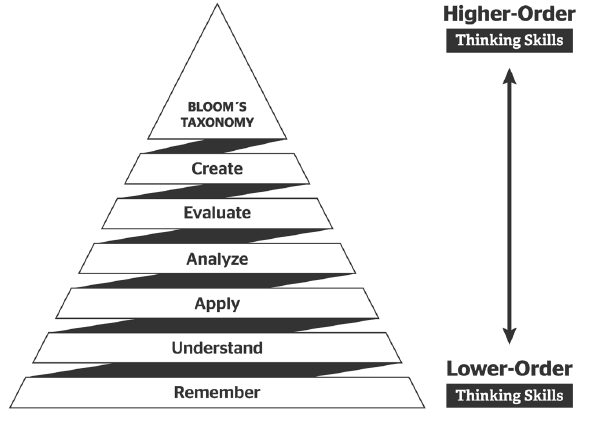
Fig. 5. Bloom’s taxonomy verbs